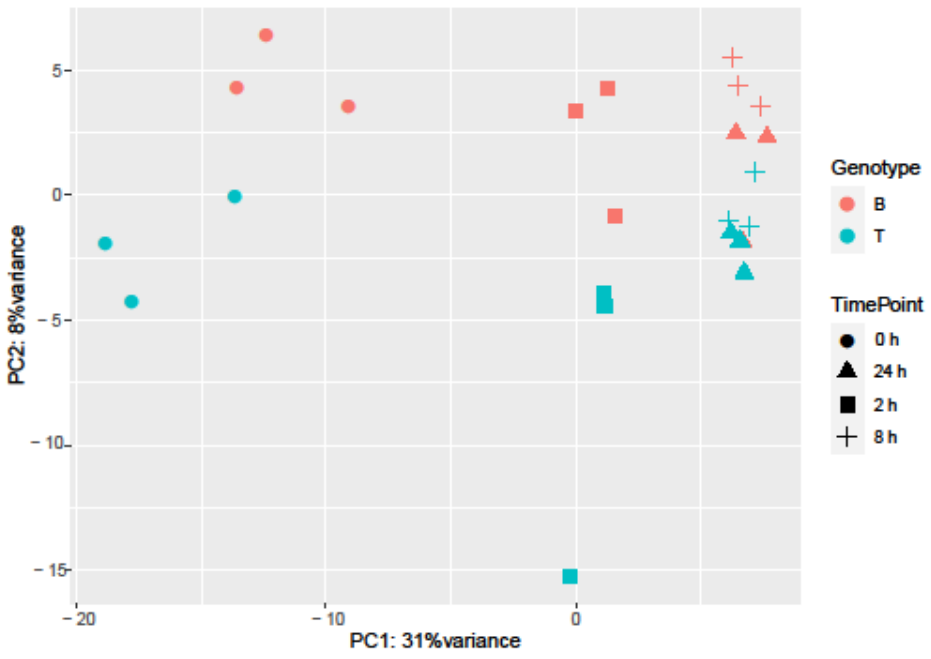
Figure 3. Sources of variation in barley gene expression under salt stress. Principal component analysis was employed to explore influences on variation. Genotype is represented by color (Boulifa—orange; Testour—blue) and treatment is represented by shape (0, 2, 8, and 24 h salt stress, see key at right).